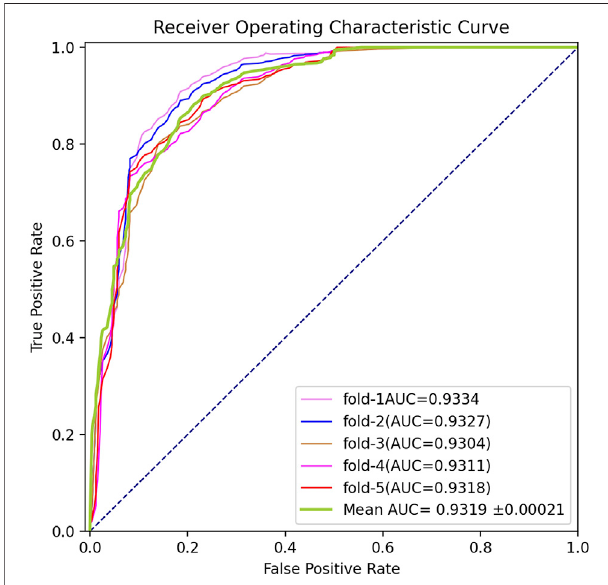
FIGURE 2 | ROC curves performed in 5- fl od cross-validation by BGANMDA, which obtained the mean AUC value and standard deviation of 0.9319 ±